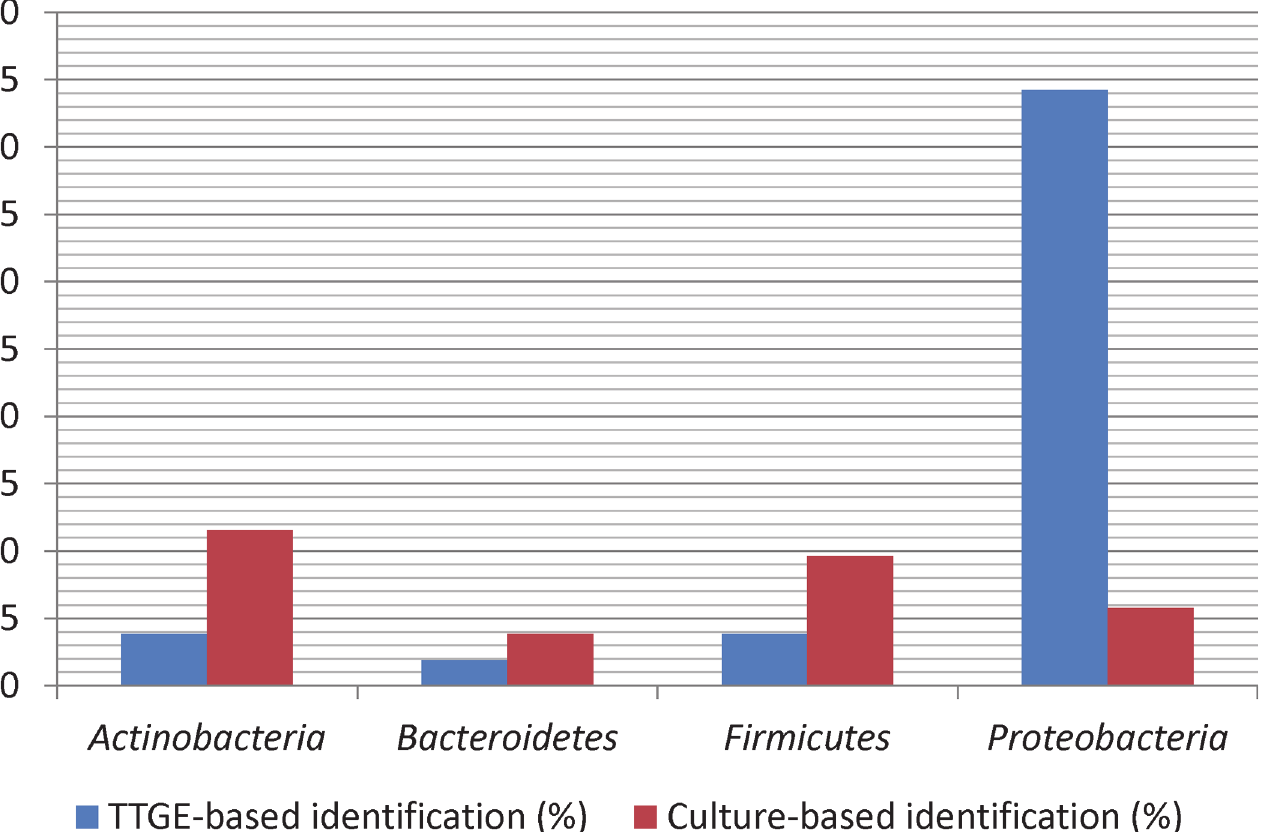
Fig 1. Prevalence of identified isolates or sequences in bacterial phyla for either TTGE- or culture-based method. Values showed the percentage of positive samples within 52 Anopheles specimens.